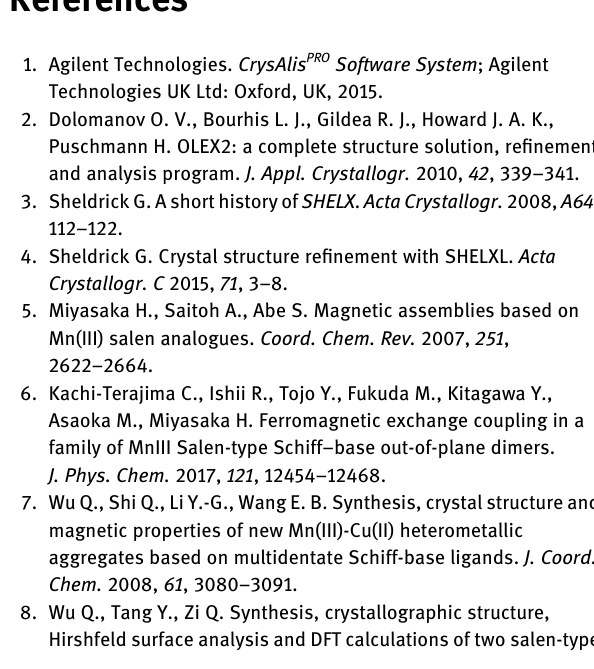
Single-crystal X-ray diffraction reveals that there is one crystallography independent Cu(II) complex in the asym- metric unit. The central Cu(II) exhibits tetra-coordinated environment which is defined by N O from the Schiff-base 2 2 ligand. The bond lengths of Cu – O(N) are in the range of 1.889(3) – 1.957(4) Å and bond angles of O(N) – Cu – O varies from 88.47(23) to 160.54(26) ° , which is compared favorably with the corresponding values observed in salen-type Cu(II) analogous [9, 10]. The dihedral angle calculated between the planes of